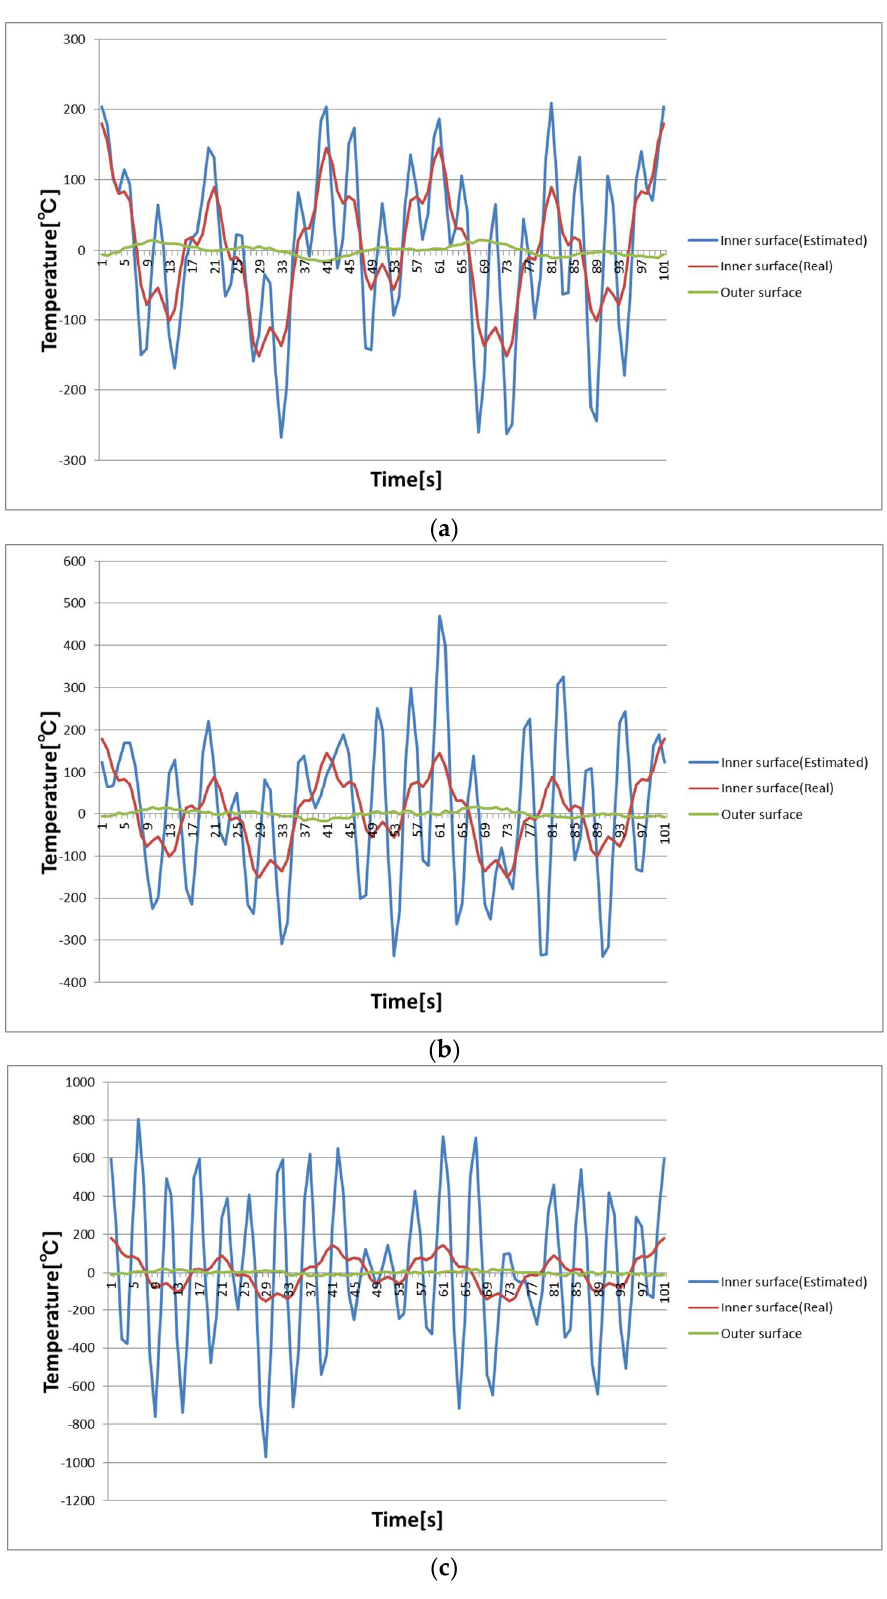
Figure 1. Estimated temperature variation on inner surface without regulation. ( a ) Observation noise of 2 °C; ( b ) Observation noise of 5 °C; ( c ) Observation noise of 8